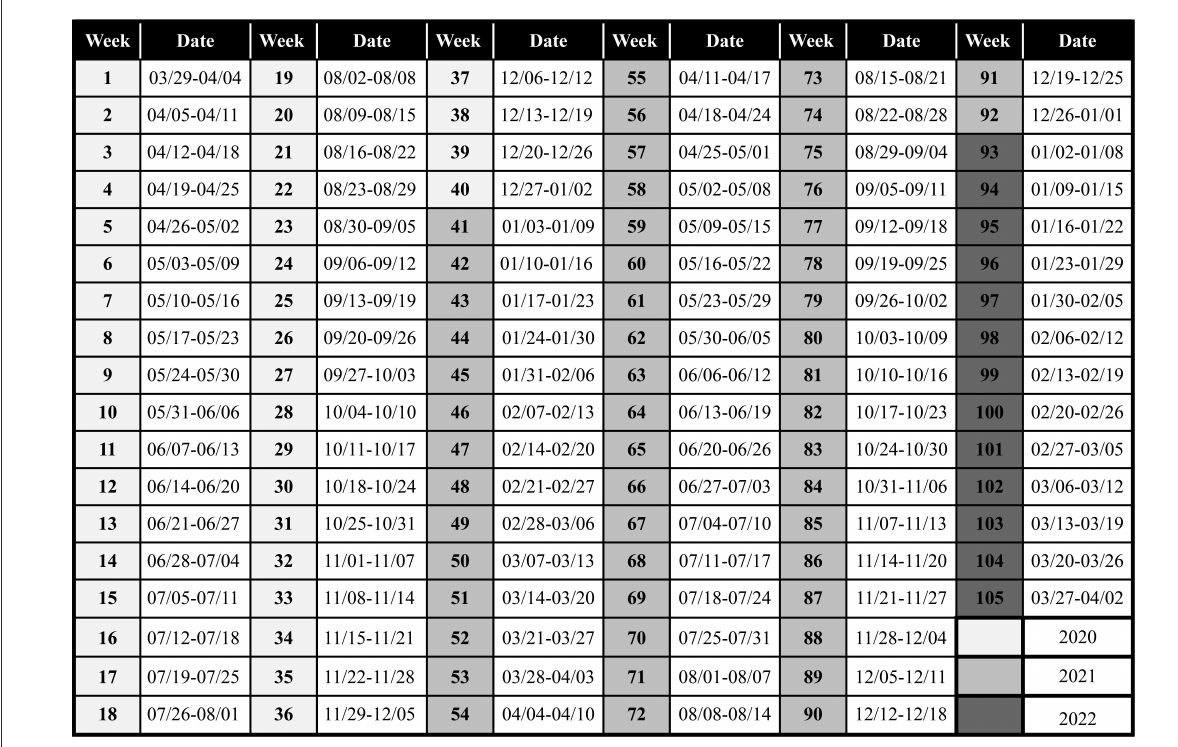
FIGURE1 One hundred and five weeks that compose the timeframe of this study.